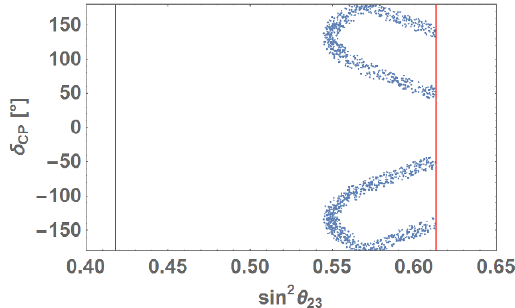
Figure 2 . The prediction of J CP versus sin 2 (cid:18) 23 for NH in model I(a). The vertical red lines represent the upper and lower bounds of the experimental data with 3 (cid:27) .